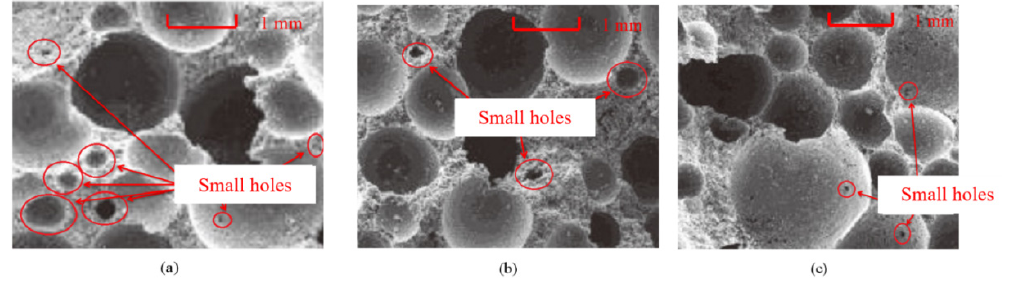
Figure 8. Microscopic images of small holes at the ages of 28 days with the sand-to-cement ratio ( R sc ) of 2 at the water-to-cement ratio ( R wc ) of ( a ) 0.50, ( b ) 0.65 and ( c ) 1.00.